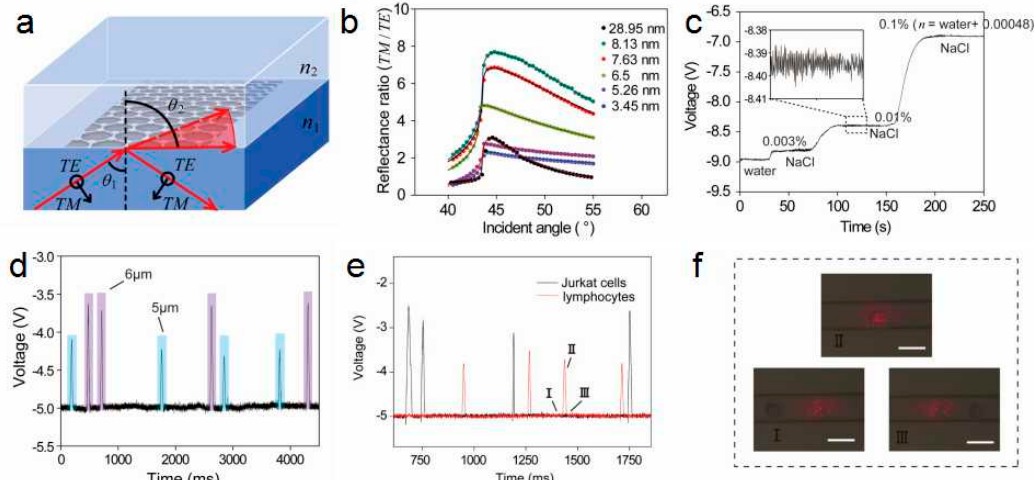
Figure 6. ( a ) Schematic of the enhanced sensitivity and resolution of refractive index (RI) sensing of h-rGO. ( b ) Angle-dependent reflectance ratio (TM / TE) plots of di ff erent thicknesses of h-rGO. ( c ) Real-time signal of di ff erent ultralow concentrations of NaCl solution. ( d ) Discrete time-dependent changes in voltage that corresponds to PS microspheres as they roll across the h-rGO detection window. The light blue and light purple areas represent the discrete voltage signals of 5 and 6 µ m PS microspheres, respectively. ( e ) Discrete time-dependent changes in voltage that corresponds to a single lymphocyte or Jurkat cell as it rolls across the detection window. The black and red lines represent Jurkat cells and lymphocytes, respectively. ( f ) Microscopic images of the h-rGO detection window as lymphocytes roll across it. The scale bar is 15 µ m, and the height of the microfluidic channel is approximately 9 µ m. Reproduced from [32] with permission of the American Chemical